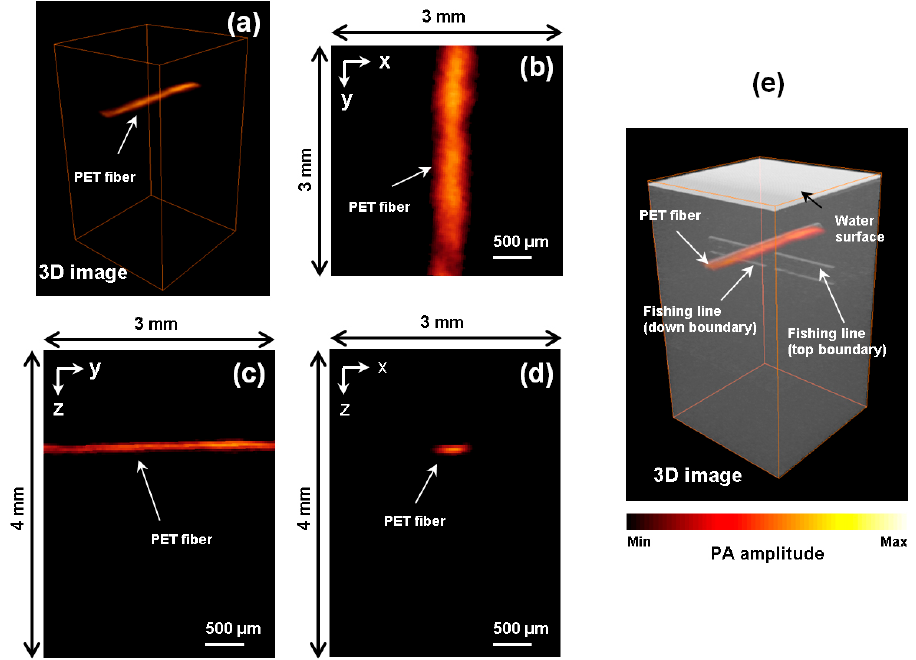
Figure 5. PAT measurement of the crossed fishing line and black PET fiber embedded in 5% solution of milk and water: ( a ) 3D PAT image of the phantom. ( b – d ) Cross-sectional images in the xy plane, xz plane, and yz plane at the center of the PET fiber. ( e ) Merged 3D PAT and OCT image. The 3D rendered images can be viewed online at Video 1.